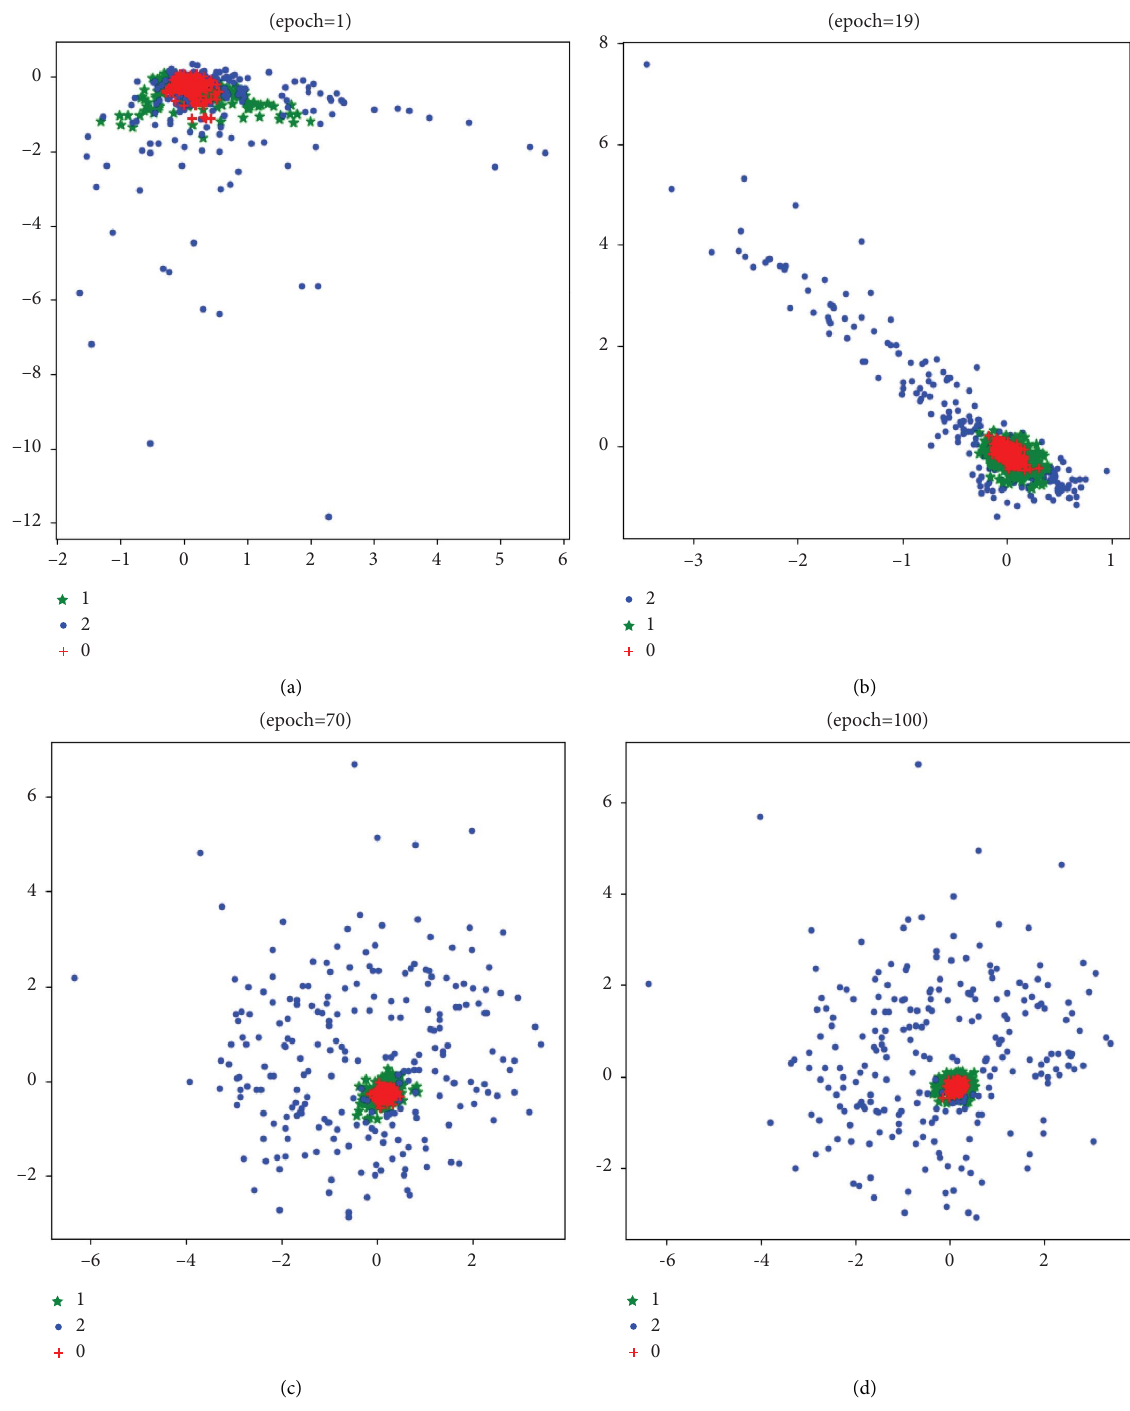
Figure 11: Distribution of MW-CVAE latent space. (a) Epoch � 1. (b) Epoch � 19. (c) Epoch � 70. (d) Epoch �